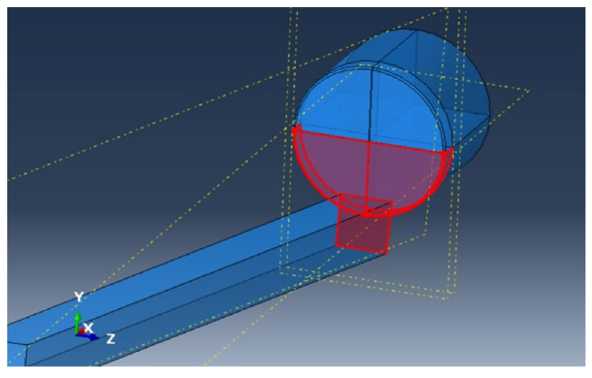
Fig. 2 Interacting surfaces of formation and cutter